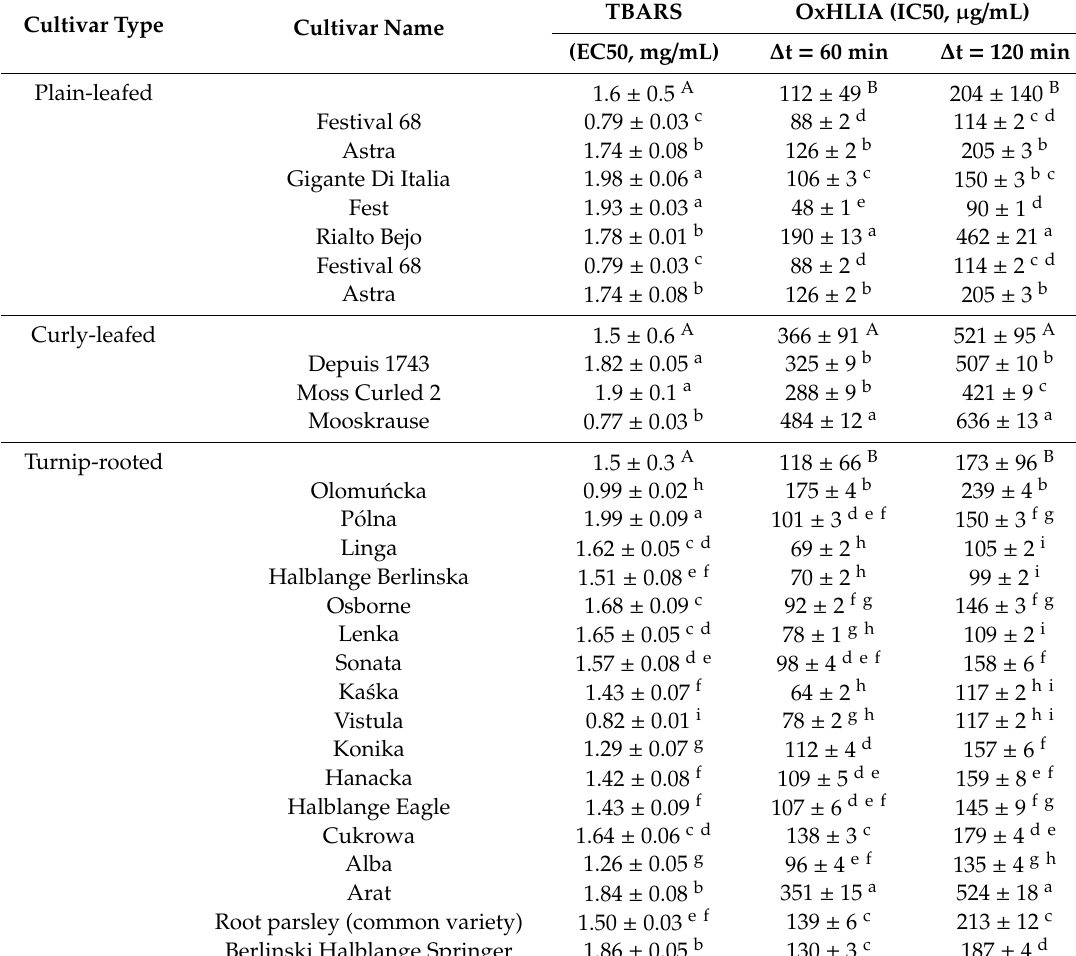
Table 3. Antioxidant activities of the hydroethanolic extracts of the tested parsley leaves (mean ± SD, n =